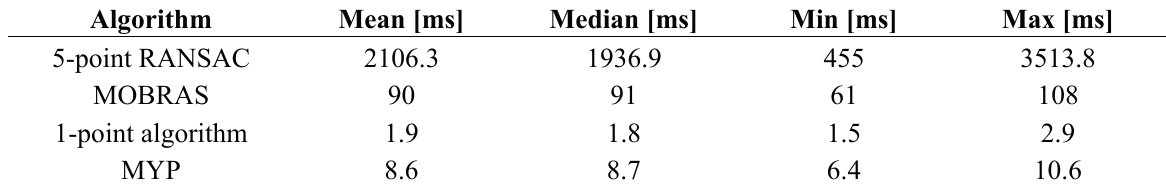
Table 2. Execution time of outlier rejection process.